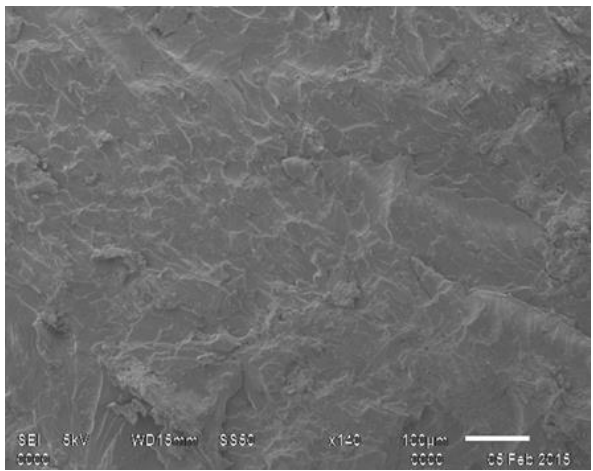
Figure 9: Scanning electron micrograph for (CY-230 + 10 wt% HY-